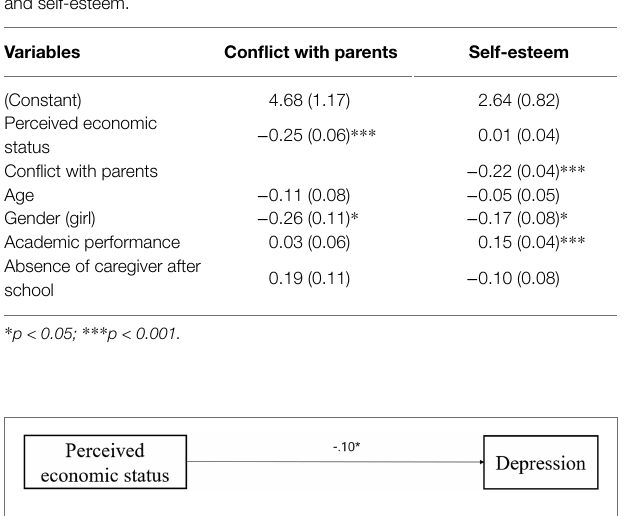
TABLE 2 | Direct effects of perceived economic status on conflict with parents and self-esteem.